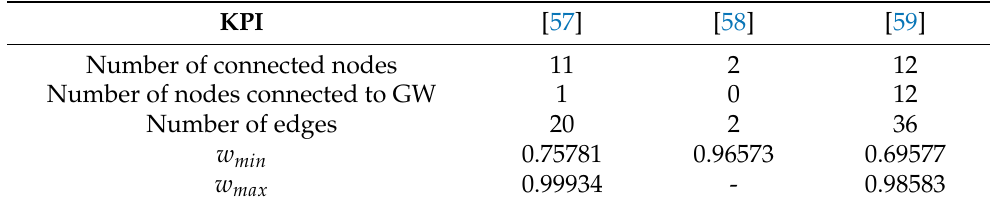
Figure 9. Communication graphs for the technical solutions in [59]. Table 8. Communication graph-based evaluation of technical solutions in